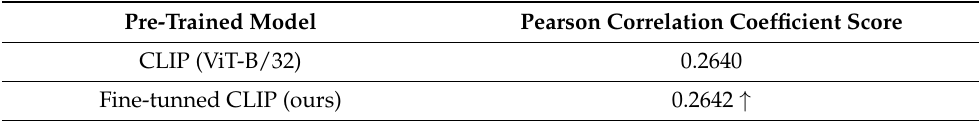
Table 9. The Pearson correlation coefficient score between CN and the corresponding color card dataset before and after fine-tuning at 500 epochs.